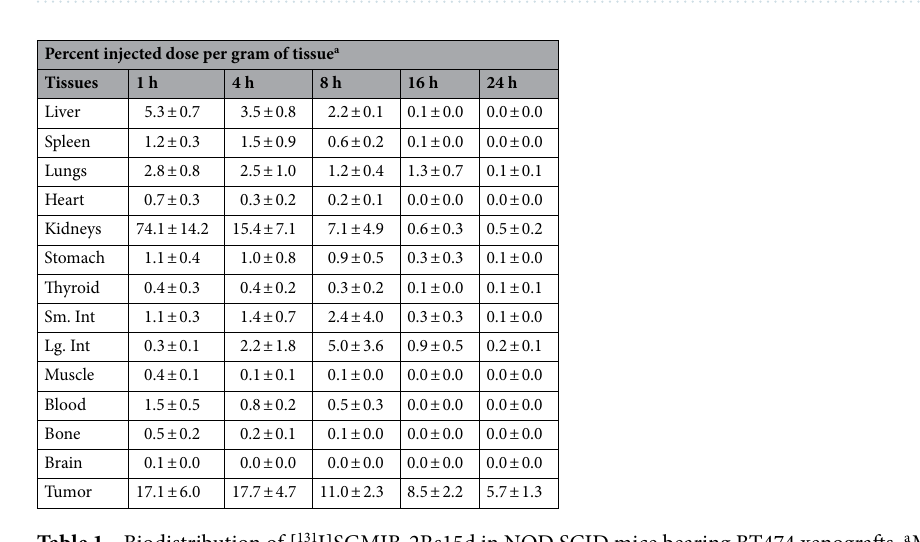
Table 1. Biodistribution of [ 131 I]SGMIB-2Rs15d in NOD SCID mice bearing BT474 xenografts. a Mean ± SD (n =